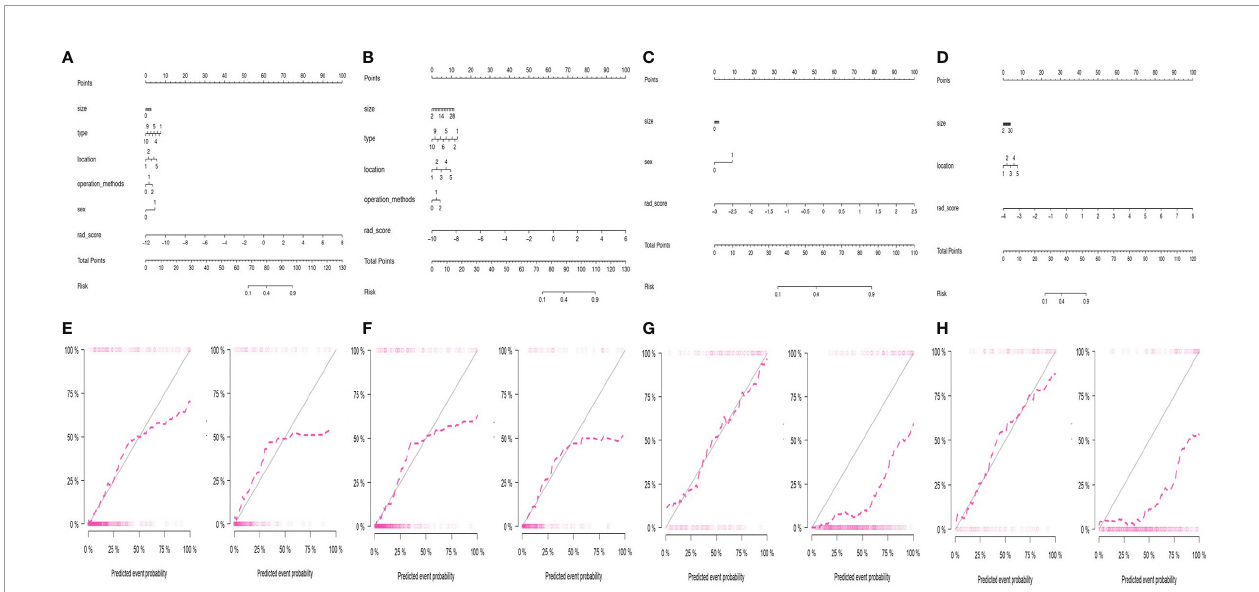
FIGURE 3 | Performance of different clinical-RNs. (A,E) CT-based clinical-RN1; (B, F) CTE-basedclinical-RN1; (C,G) CT-based clinical-RN2; (D, H) CTE-based clinical- RN2. For clinical-RNs (the fi rst row),a straight line was drawn to determine the points for each feature (forexample, features including size, type, location, operation methods, sex and radscore for (A) . The fi nal “ Total points ” were calculatedby summingthe score ofeach point represented for each feature. After the total points iscalculated, a vertical line isdrawnat the value correspondingto the line “ Total Points ” , andthe value correspondingto the line “ Risk ” represents the probability of MBL.The corresponding calibration curves of the clinical-RNs inthe trainingset (left) and validation set (right) were displayed inthe second row.The nomogram-predicted probabilities were shownin x axisand the actual probability was represented on the y axis. The closer the two dotted line, the better the